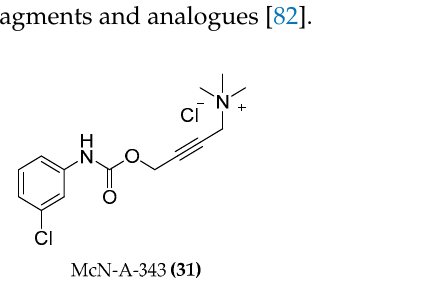
Figure 12. Structures of McN-A-343.